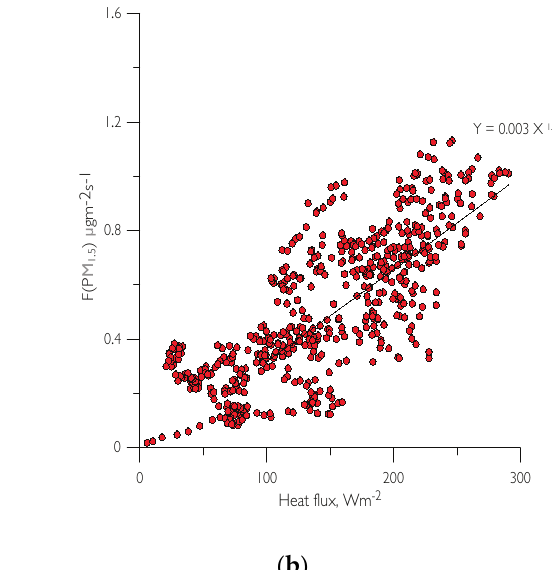
Figure 11. Correlation diagrams between the aerosol flux ( PM 1.5 ) and the sensible heat flux ( 𝐹 heat ). Daytime: 10:00–20:00: ( a ) Convectional entrainment of particles, non-saltation mechanism prevails for 24 July 2009; ( b ) Wind entrainment of particles, saltation mechanism prevails for 28 July 2011.